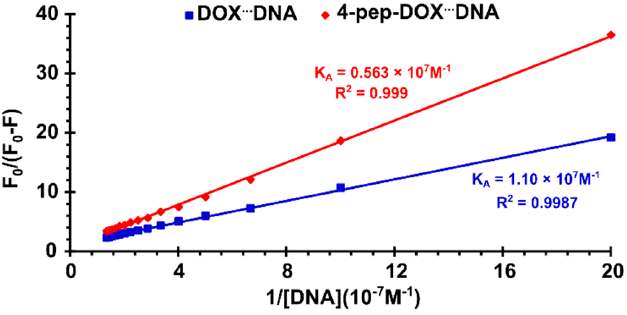
Figure 7. Lineweaver–Burk double-reciprocal curves of F 0 4-pep–DOX ... dsDNA systems in 10 mM Tris-HCl bu ff er (pH 7.2) at 25 ◦ C.